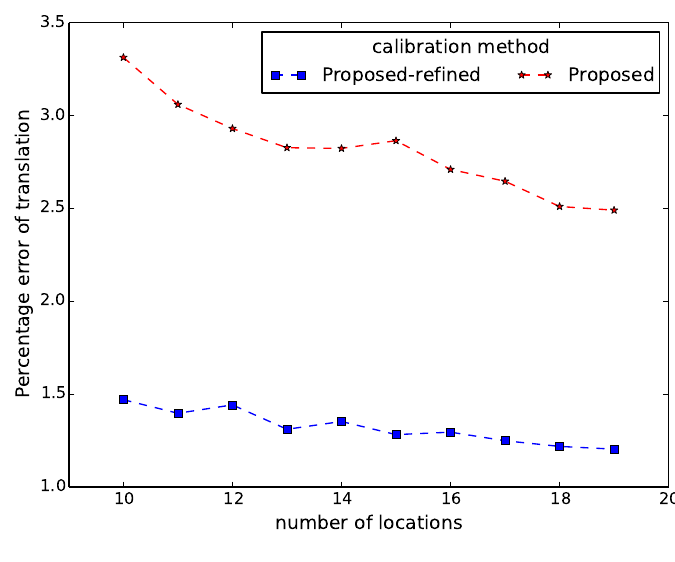
Figure 13. Relative translation error of our method (proposed) and the method after refinement (proposed-refined) using different numbers of locations. Each location yields two calibration samples (head and feet).